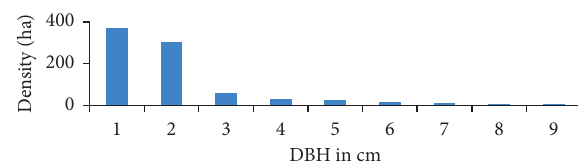
Figure 4: Size class distribution of stem density across diameter classes in Kenech